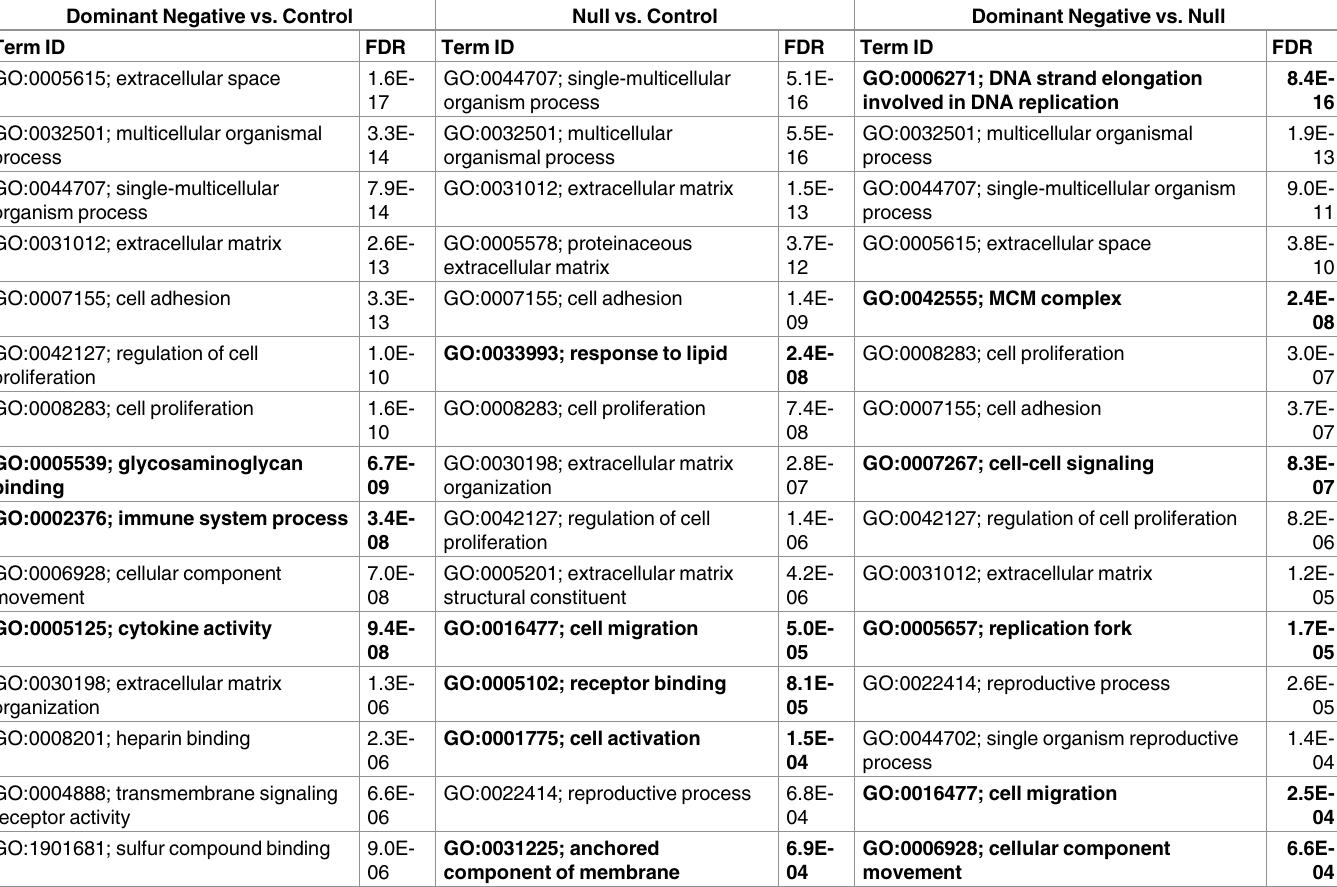
Table 3. Enriched gene ontology terms among differentially expressedgenes in COL6-RD subjects with dominant negative or null mutations com- pared to control 1 . Dominant Negative vs.